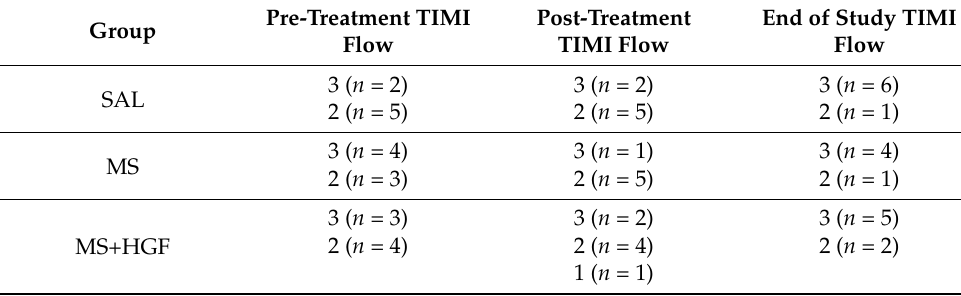
Table 2. Coronary flow evolution at the different study phases. Pre-Treatment Group